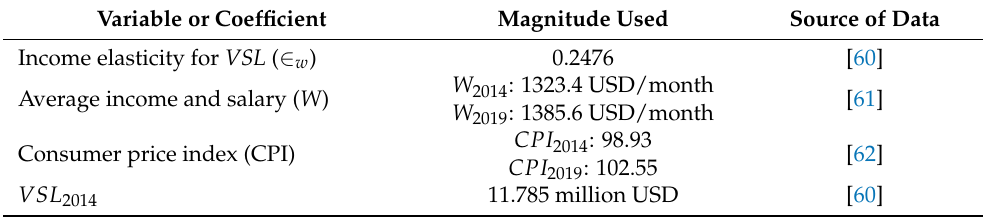
Table 6. All related coefficients and data used in the estimation of the value of a statistical life ( VSL ). Variable or Coefficient Magnitude Used Source of Data Income elasticity for VSL ( ∈ w )